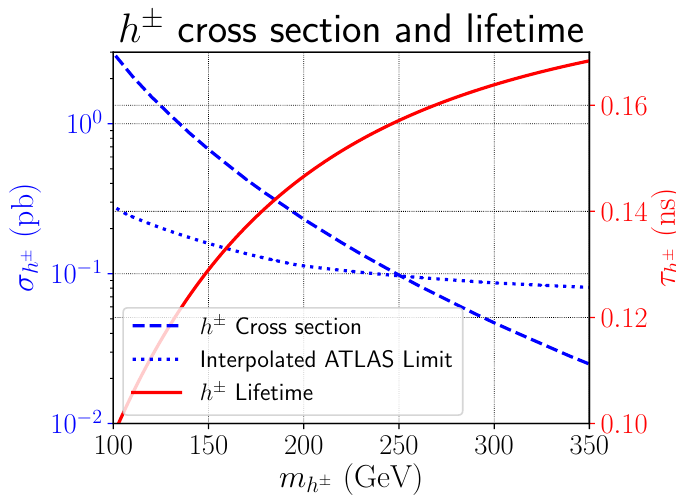
Figure 3. Charged triplet production cross section (dashed blue line) and lifetime (solid red line), along with the interpolated 95% con(cid:12)dence upper limit on the chargino production cross section (dotted blue line) arising from disappearing tracks searches for charginos with the same mass and lifetime. The charged triplet production cross section intersects the upper limit at m and we take this to be the lower bound imposed by disappearing track